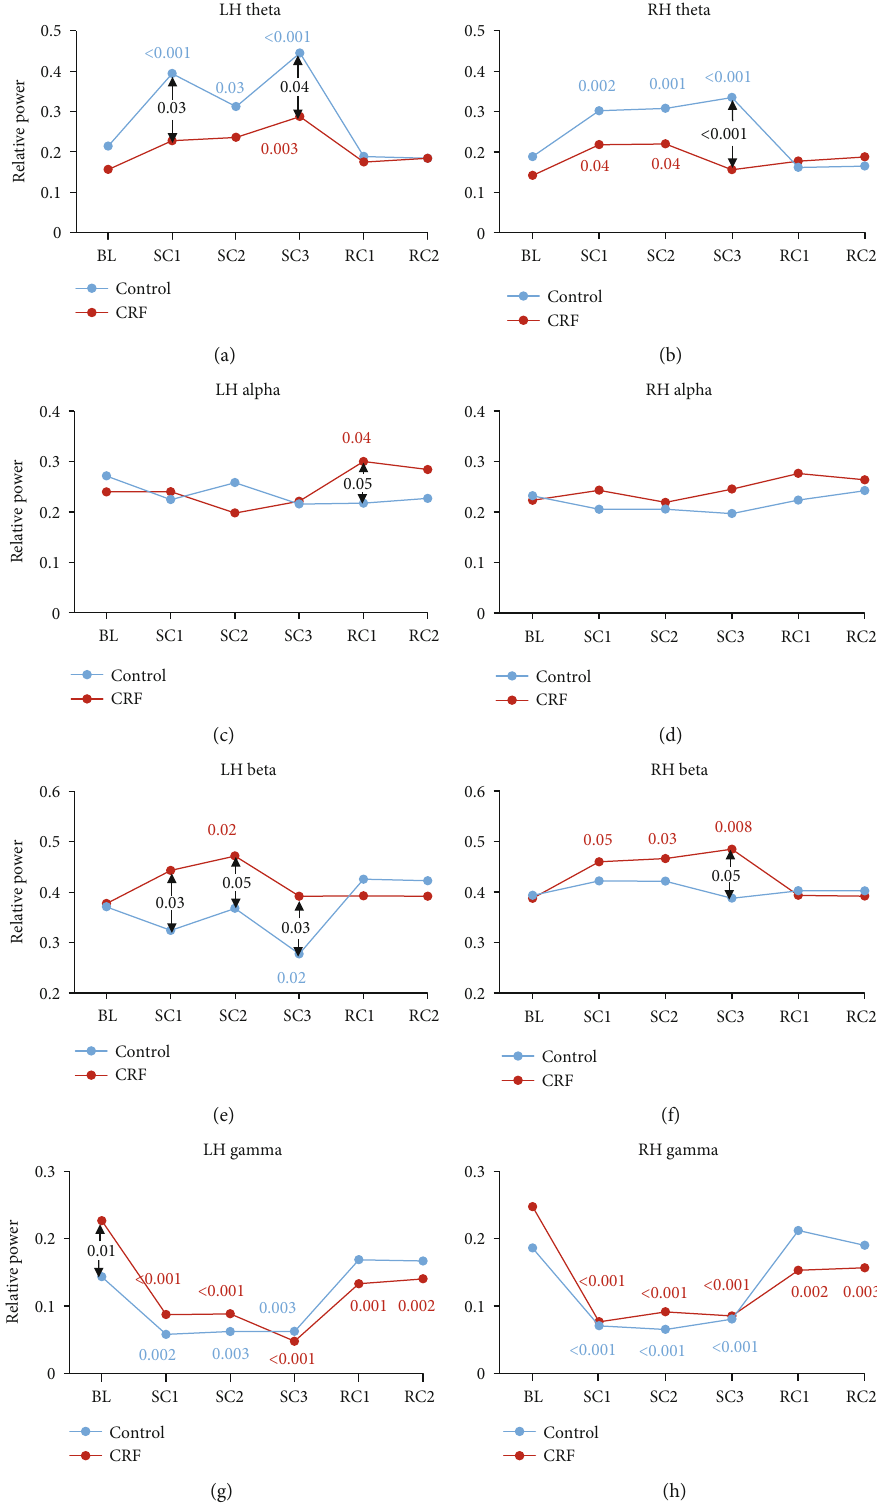
Figure 2: Relative EEG power change at each frequency band during the fatigue task for CRF (red) and healthy controls (blue) for the left (LH) and right (RH) hemispheres. Estimated marginal means are derived from the mixed linear model. Whenever signi fi cant, p values are shown in red for CRF and blue for controls for the within-group contrast analysis (compared to baseline) and in black for between-group contrast analysis. CRF: cancer-related fatigue; BL: pretask baseline; SC1, 2, and 3: beginning, middle, and end of the sustained contraction fatigue task, respectively; RC1 and 2: recovery period right after the end of the task and 2 min